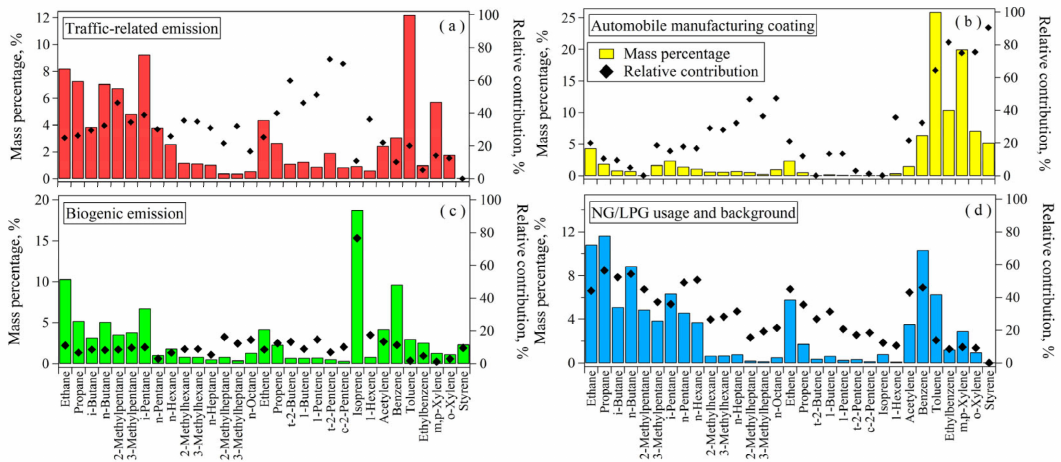
Figure 7. Chemical profiles of four factors resolved by PMF: ( a ) tra ffi c-related emission, ( b ) automobile manufacturing coating, ( c ) biogenic emission; and ( d ) NG / LPG usage and